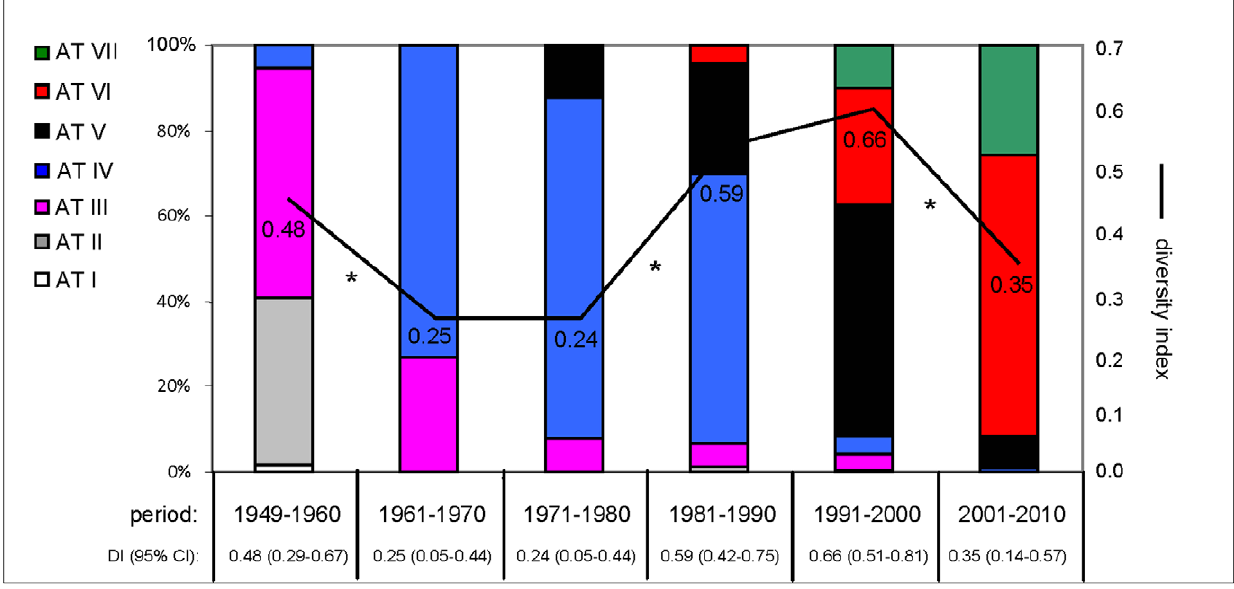
Figure 3. Frequency of allele types and genetic diversity of the Dutch B.pertussis population in the period 1949–2010. The diversity index (DI) and 95% confidence interval (CI) for each period, based on the sequence types (STs), were calculated using the Hunter and Gaston’s modification (Hunter and Gaston 1988) of the Simpson’s diversity index and are indicated. Frequencies of allele types are calculated for each period and coloured as in Fig. 1. Significant differences in DI between periods are indicated with asterisks. Abbreviations: AT, allele type; N, number of strains; DI, diversity index; CI, 95% confidence interval.